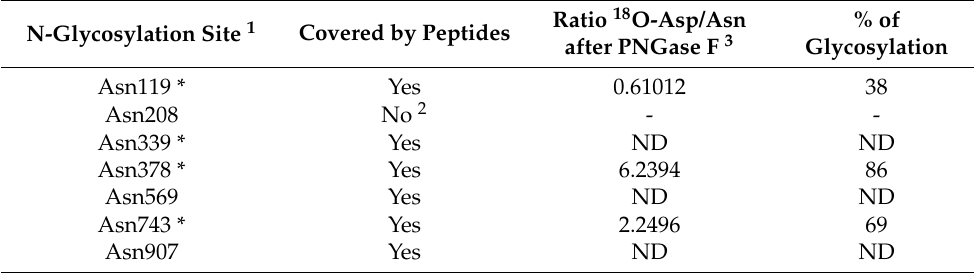
Table 2. Occupancy of glycosylation sites of CP determined by enzymatic 18 O deamidation after PNGase F digest.